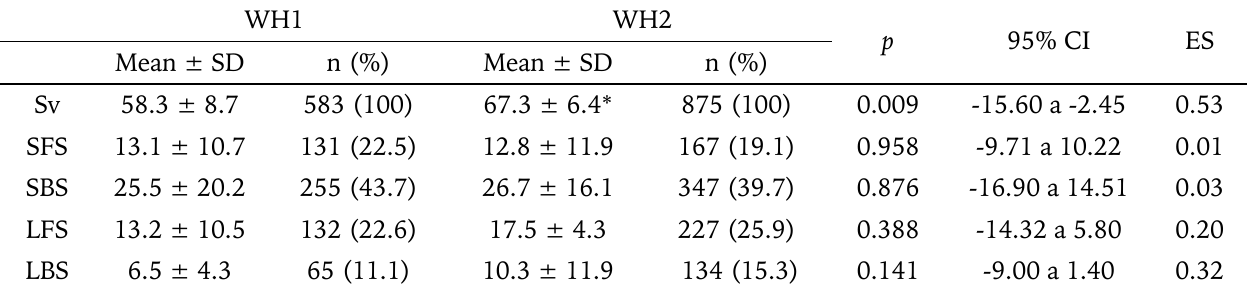
Number for each types of service performed in games of classes WH1 and WH2. Data are presented as mean and standard deviation, and as a total number (n) per class with percentage (%).